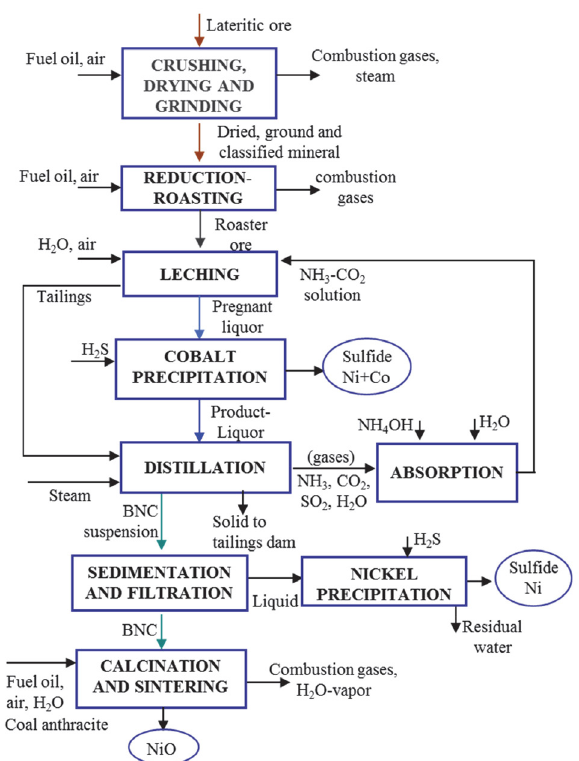
Figure 1. Process flowsheet of the nickel and cobalt producer plant in